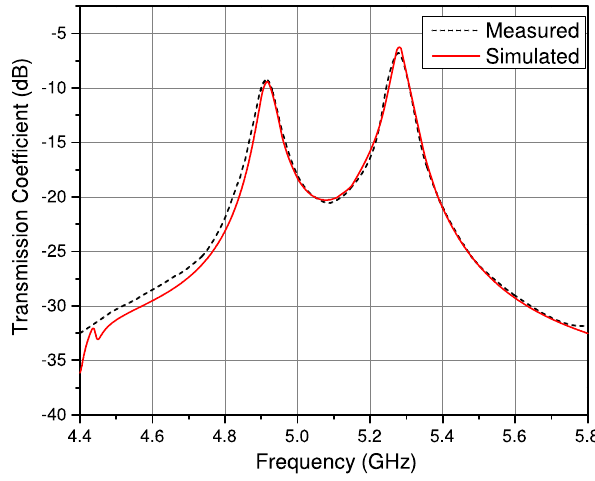
Figure 3. Simulated and measured transmission coefficient of the SIW filter.